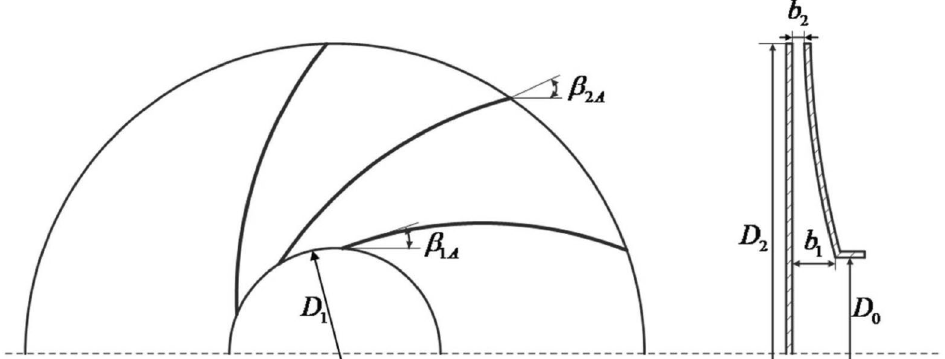
Figure 5. Main parameters of impeller.